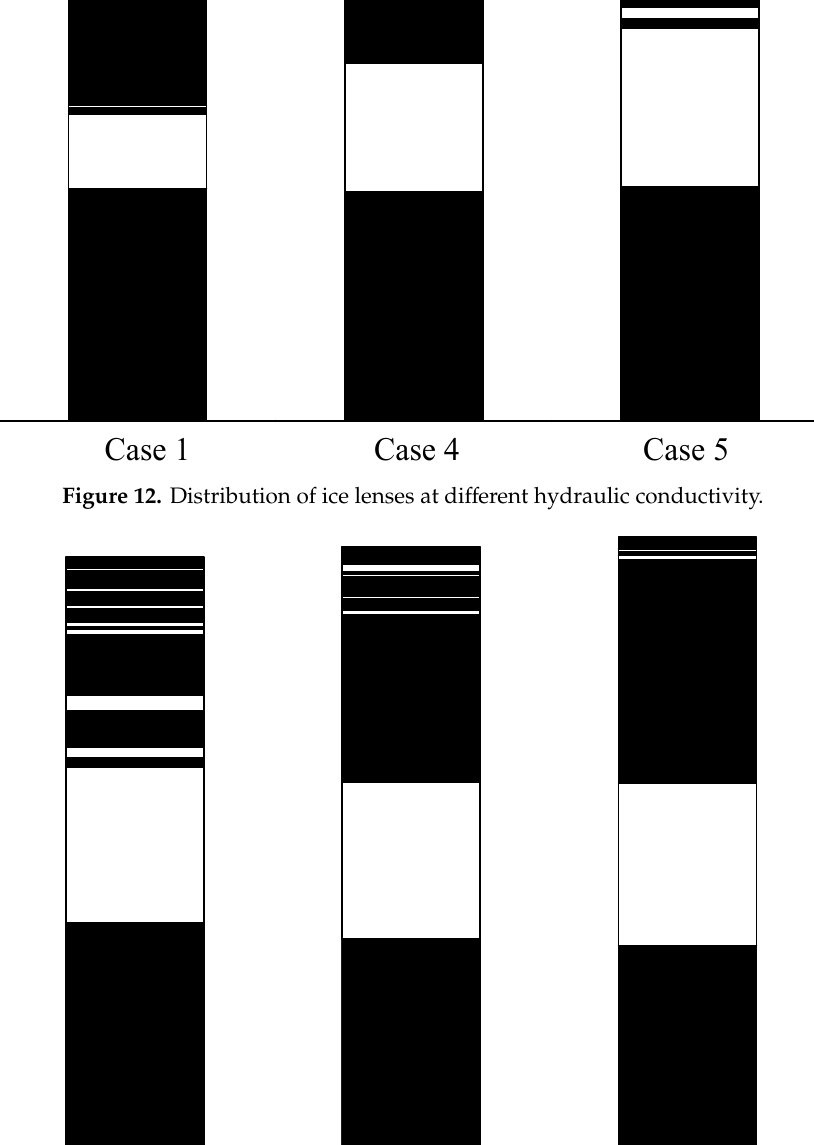
Figure 13. Distribution of ice lenses at different thermal conductivity of solid particles.